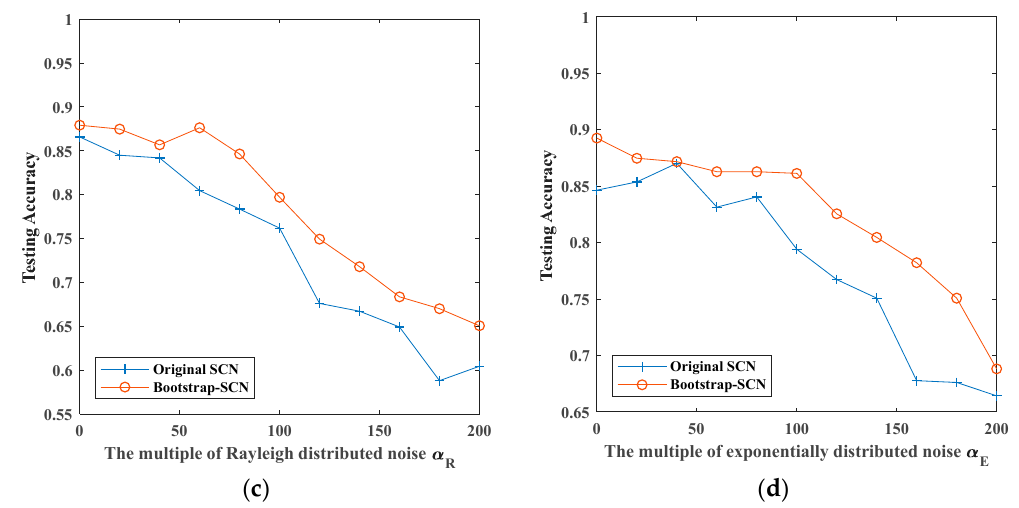
Figure 12. The maximum testing accuracy of original SCN and Bootstrap-SCN with different noises: ( a ) white Gaussian noise; ( b ) white uniform noise; ( c ) Rayleigh distributed noise; ( d ) exponentially distributed noise.